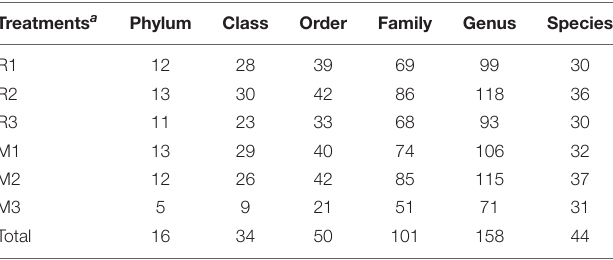
TABLE 2 | Number of identified gut bacterial taxonomic categories in rice- and maize-feeding Cnaphalocrocis medinalis for three generations. Treatments a Phylum Class Order